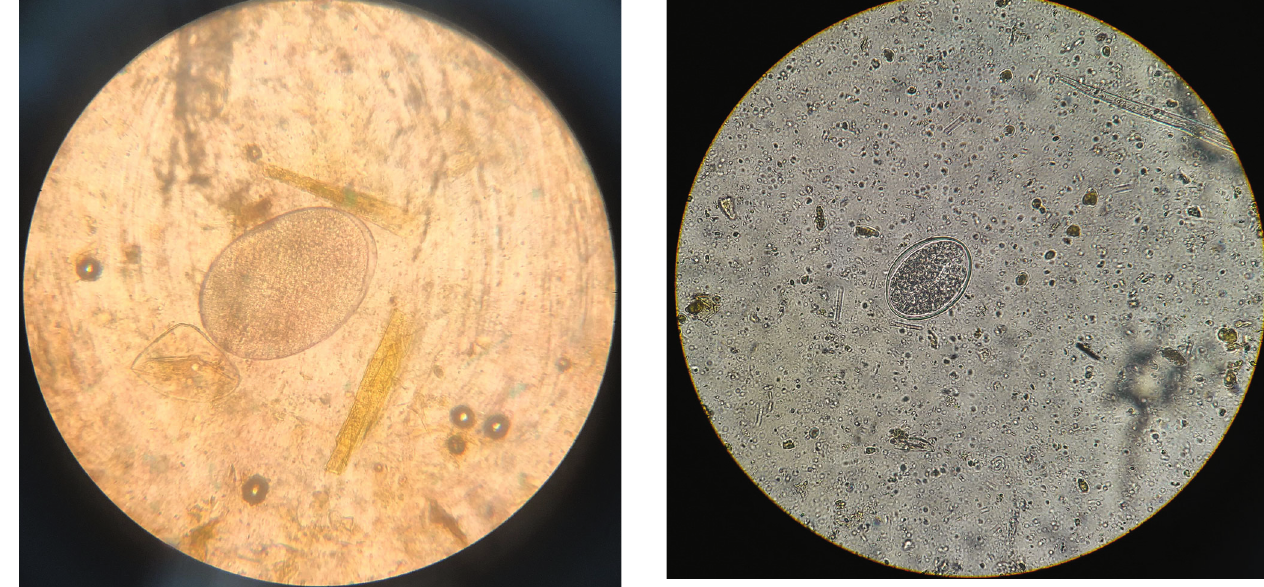
Figure 3: The egg of Fasciola sp. is large and operculated, and ovoid contains a large un-segmented ovum in a mass of yolk